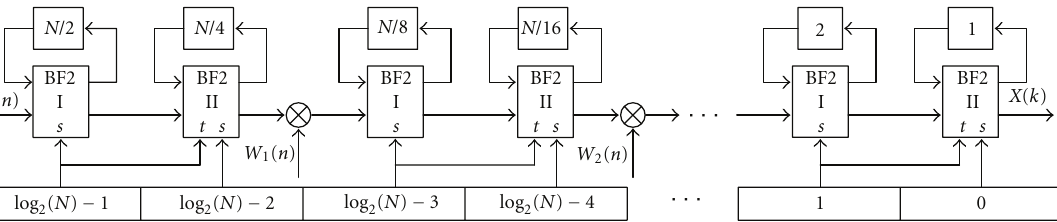
Figure 4: N -point R2 2 SDF pipeline FFT processor architecture.